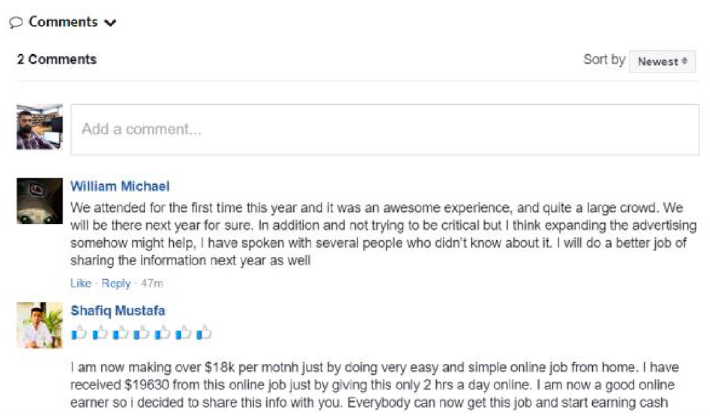
Figure 2. Example acquired from www.islandpacket.com.